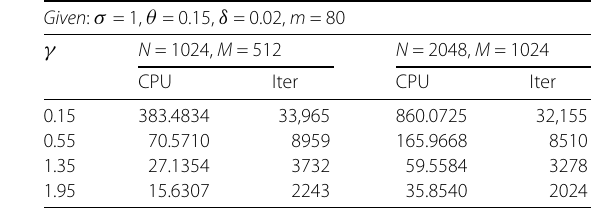
Table 2 The convergence of Algorithm 3.1 with various γ